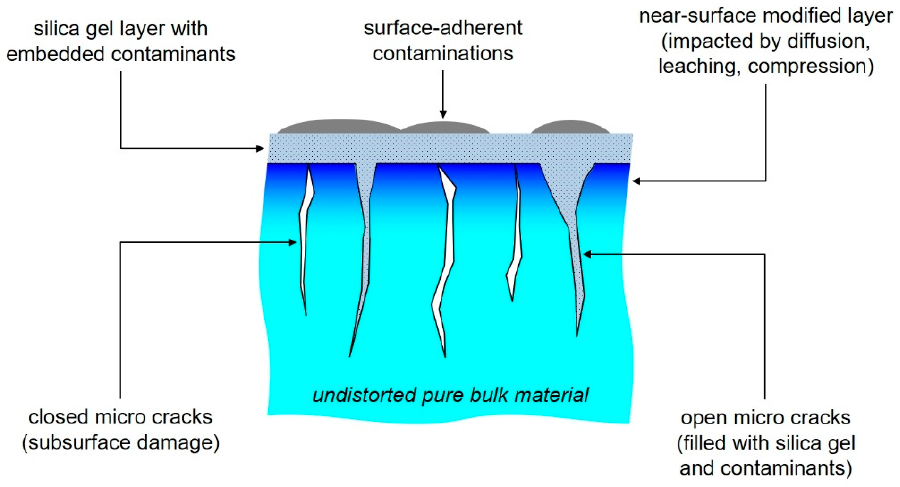
Figure 1. Overview on possible defects of classically manufactured silicon dioxide-based glass surfaces